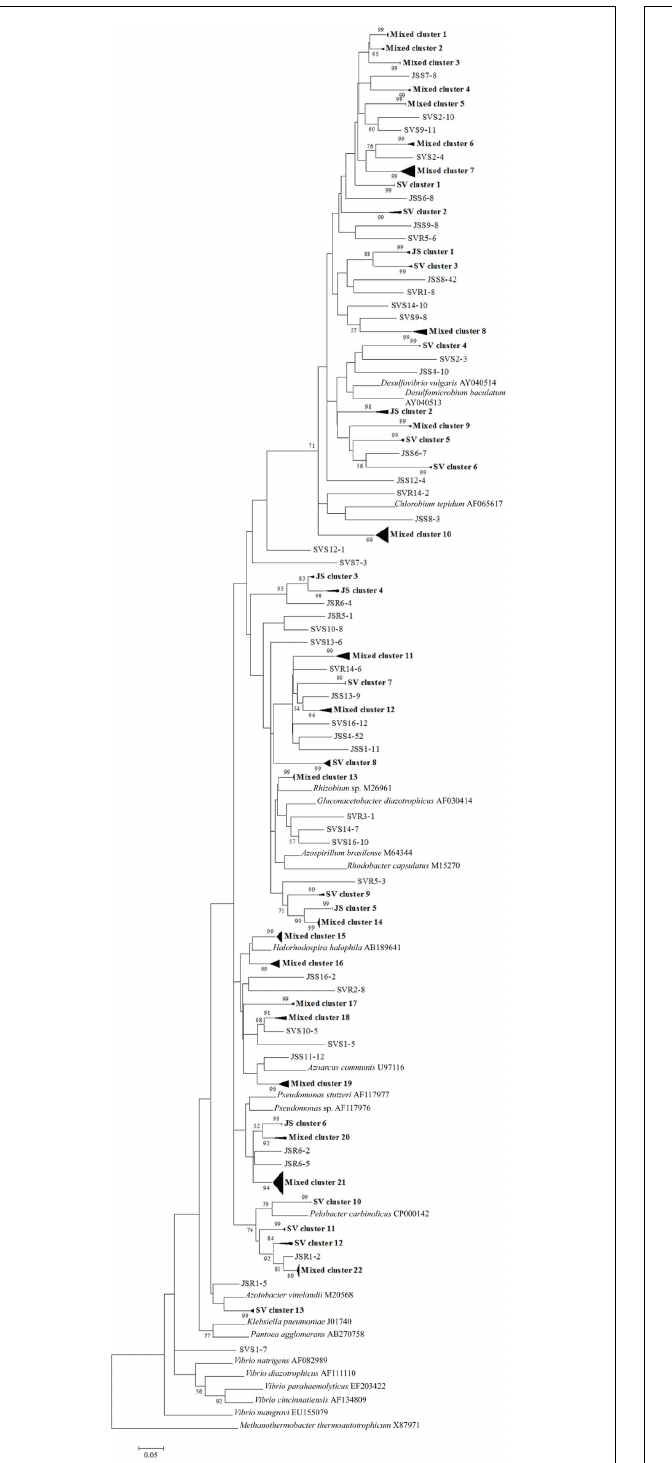
FIGURE 5 | Phylogenetic analysis of all nifH sequences from DGGE bands of rhizoplane (R) and rhizosphere (S) samples from the high marsh plant zones (nucleotide sequences, Neighbor-Joining, Jukes Cantor correction, complete deletion of gaps and missing data, 1000 bootstrap replicates). Boot strap values below 50% are not shown. Abbreviations: JS, Juncus roemerianus stand; SV, Salicornia virginica .